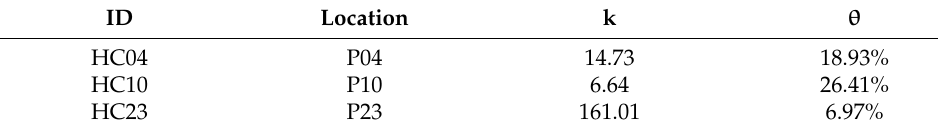
Table 7. Loss coefficient k required in hydraulics control elements.